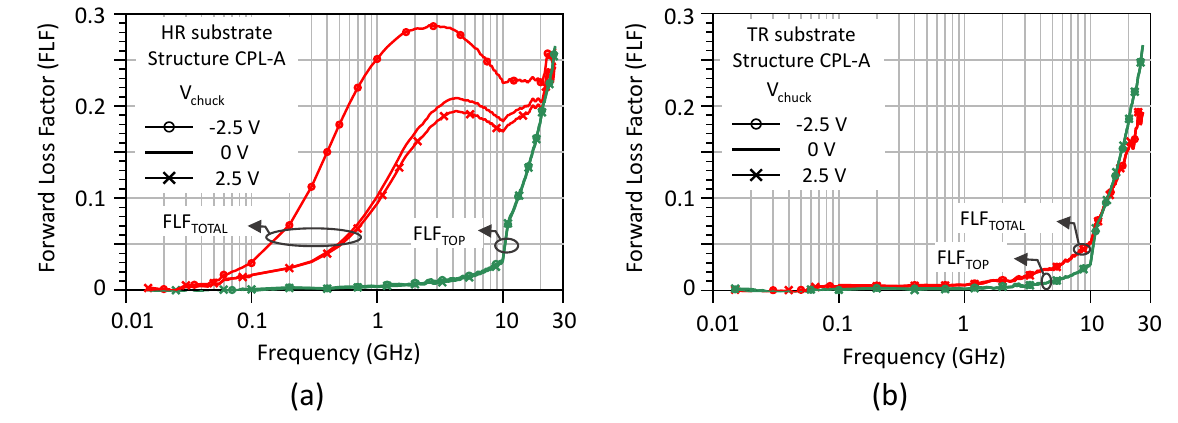
Figure 7. Forward loss factor of structure CPL-A at chuck bias of − 2.5, 0 and 2.5 V. FLF TOTAL and FLF TOP are the loss factors before and after substrate removal, respectively. ( a ) HR starting substrate; ( b ) TR starting substrate. Table 2. Δ S 21 values depicting the difference in substrate coupling before and after removal of sub- strate at chuck bias of 0 V.